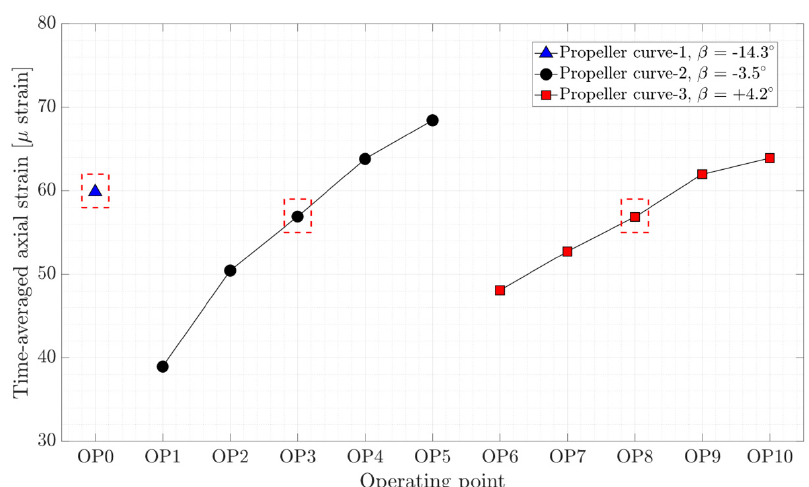
Figure 6. Time-averaged strain obtained on the runner blade.